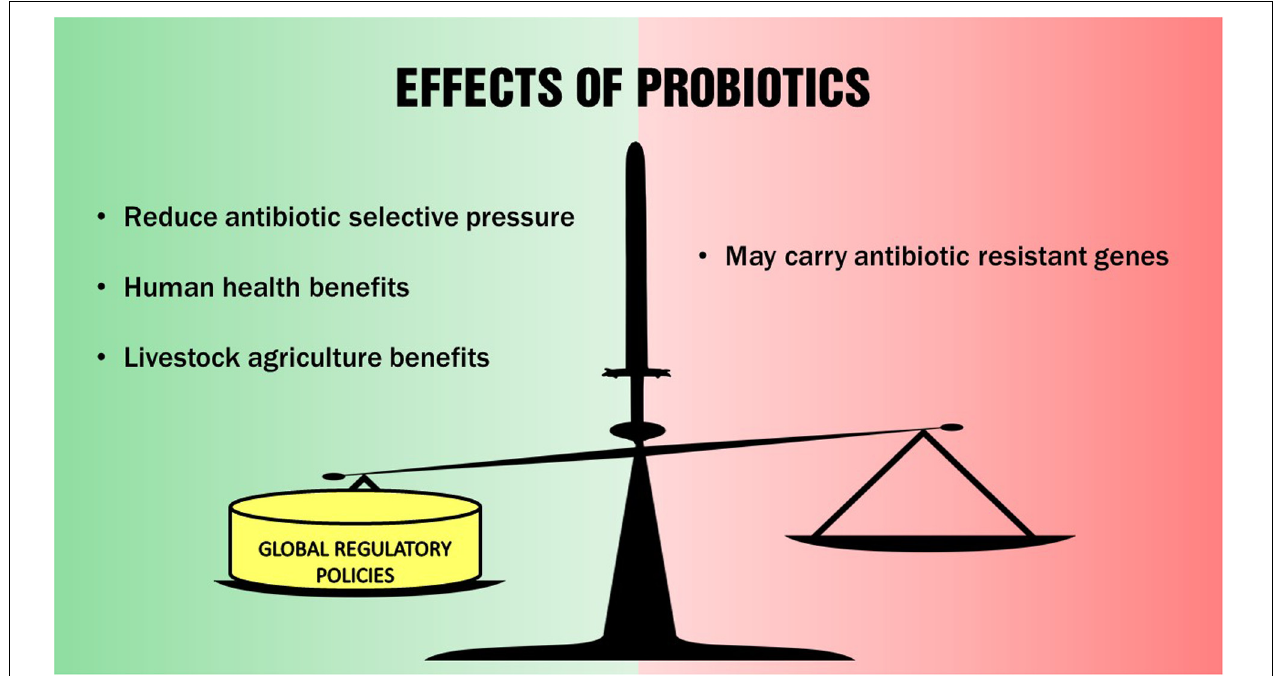
FIGURE 1 | Skewing the double-edged effects of probiotics toward positive